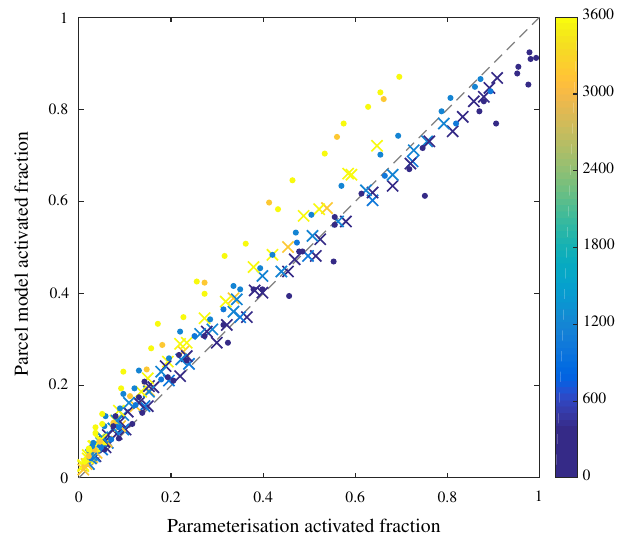
Figure 6. Activated fraction data from Figs. 3 to 5 collated into one figure. The x axis shows the activated fraction from the parameteri- sation and the y axis shows the parcel model. The crosses show the results from the cloud droplet activation scheme without SVOCs and the dots show the parameterisation with SVOCs. Markers are coloured by the total number concentration of aerosol